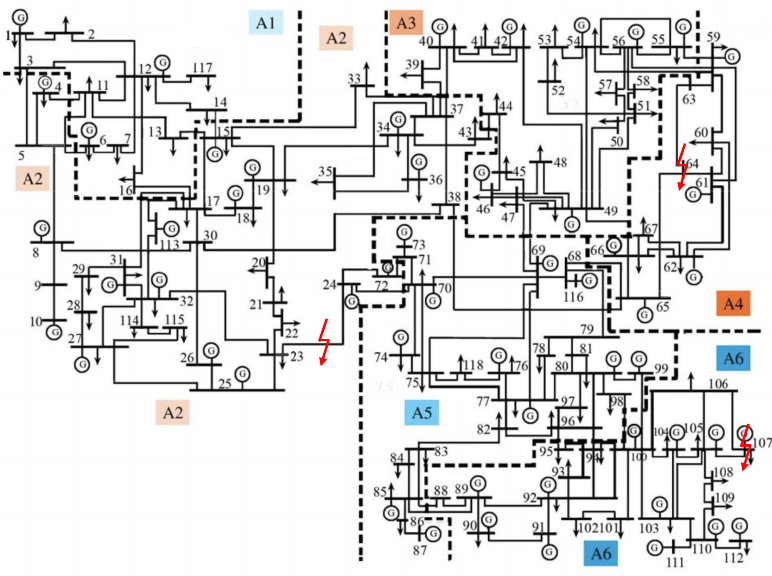
Figure 1. Topology of the standard IEEE 118-bus